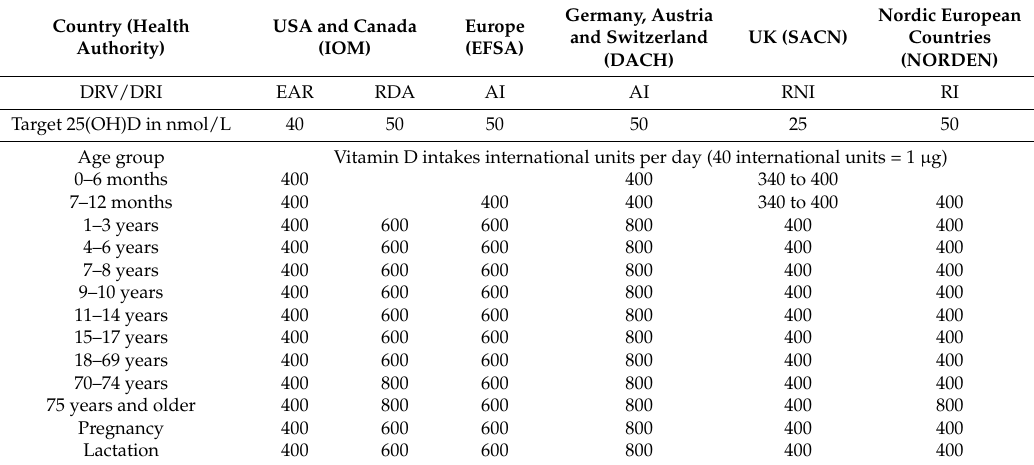
Table 1. Dietary reference values (DRV)/dietary reference intakes (DRI) for vitamin D. Country (Health